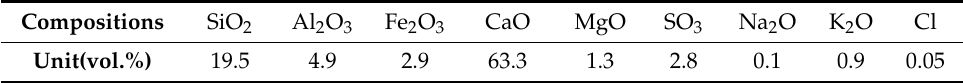
Table 1. Chemical composition of cement.